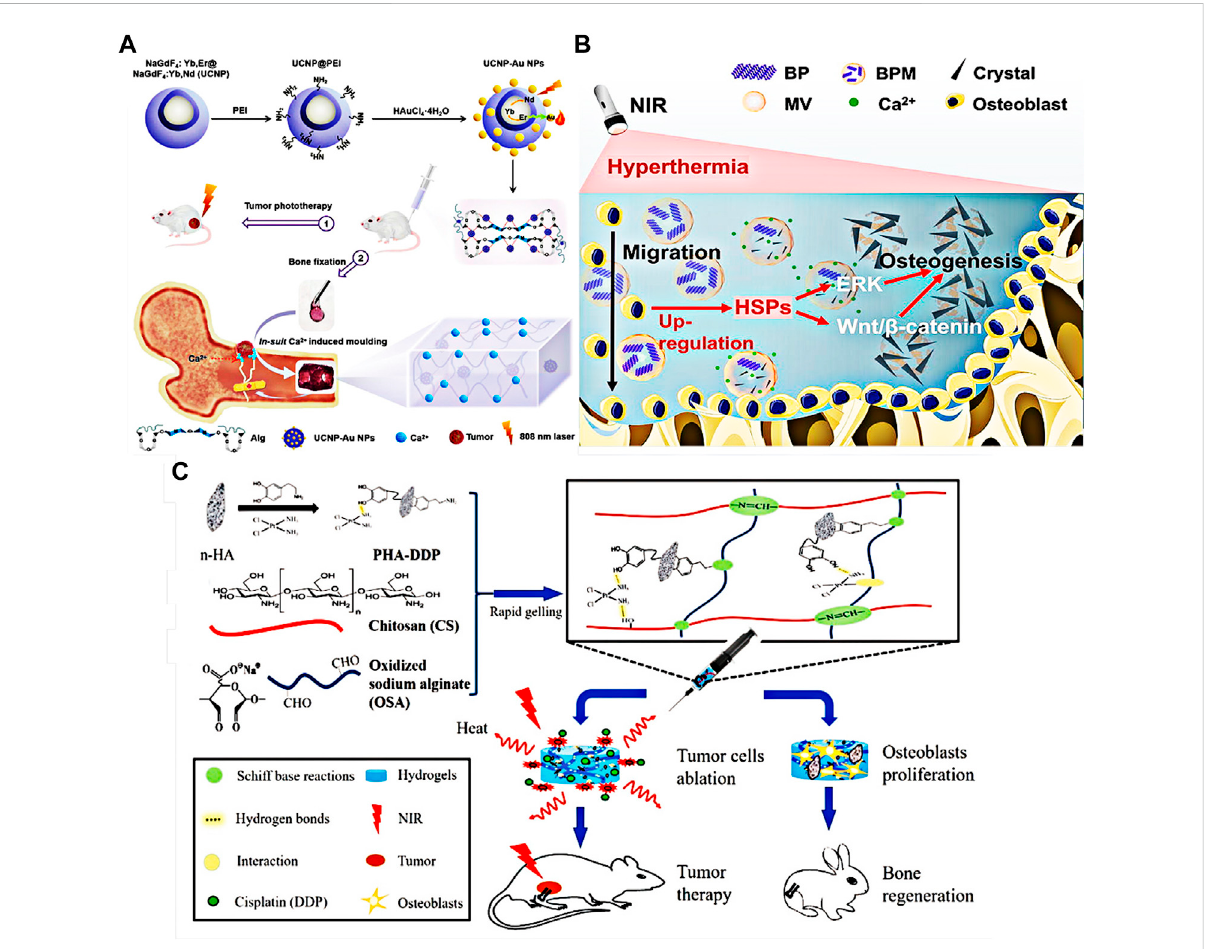
FIGURE 11 (A) Schematic diagram of preparation and principle of near-infrared hydrogel that can promote bone healing. Reproduced from ref. 46 with permission from 2021 Wiley-VCH GmbH. (B) Schematic diagram of the principle of photothermal nanohydrogel promoting bone